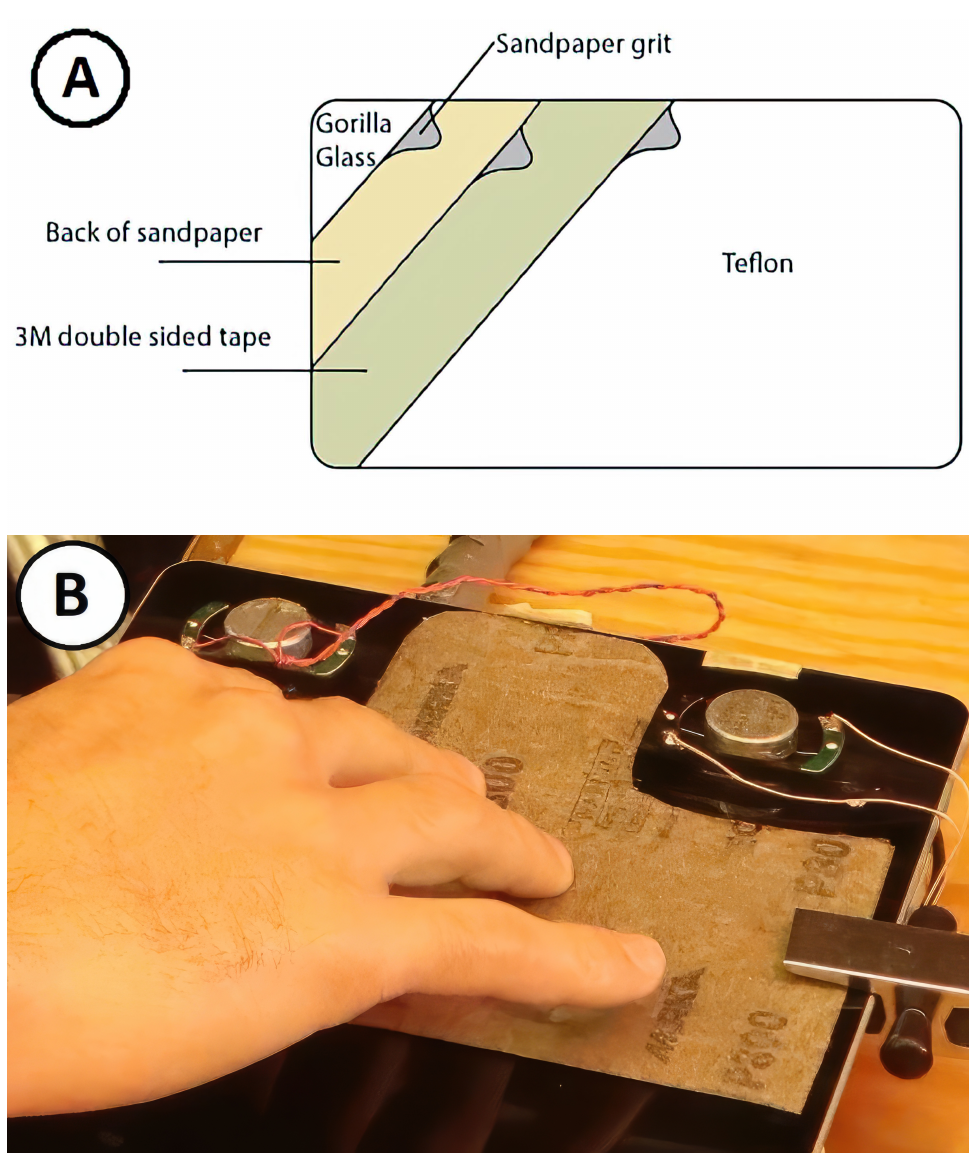
Figure 3. ( A ) Cross-section of the layers of the overlay surface. ( B ) Overlay placed on tablet surface with a participant’s hand exploring for localized